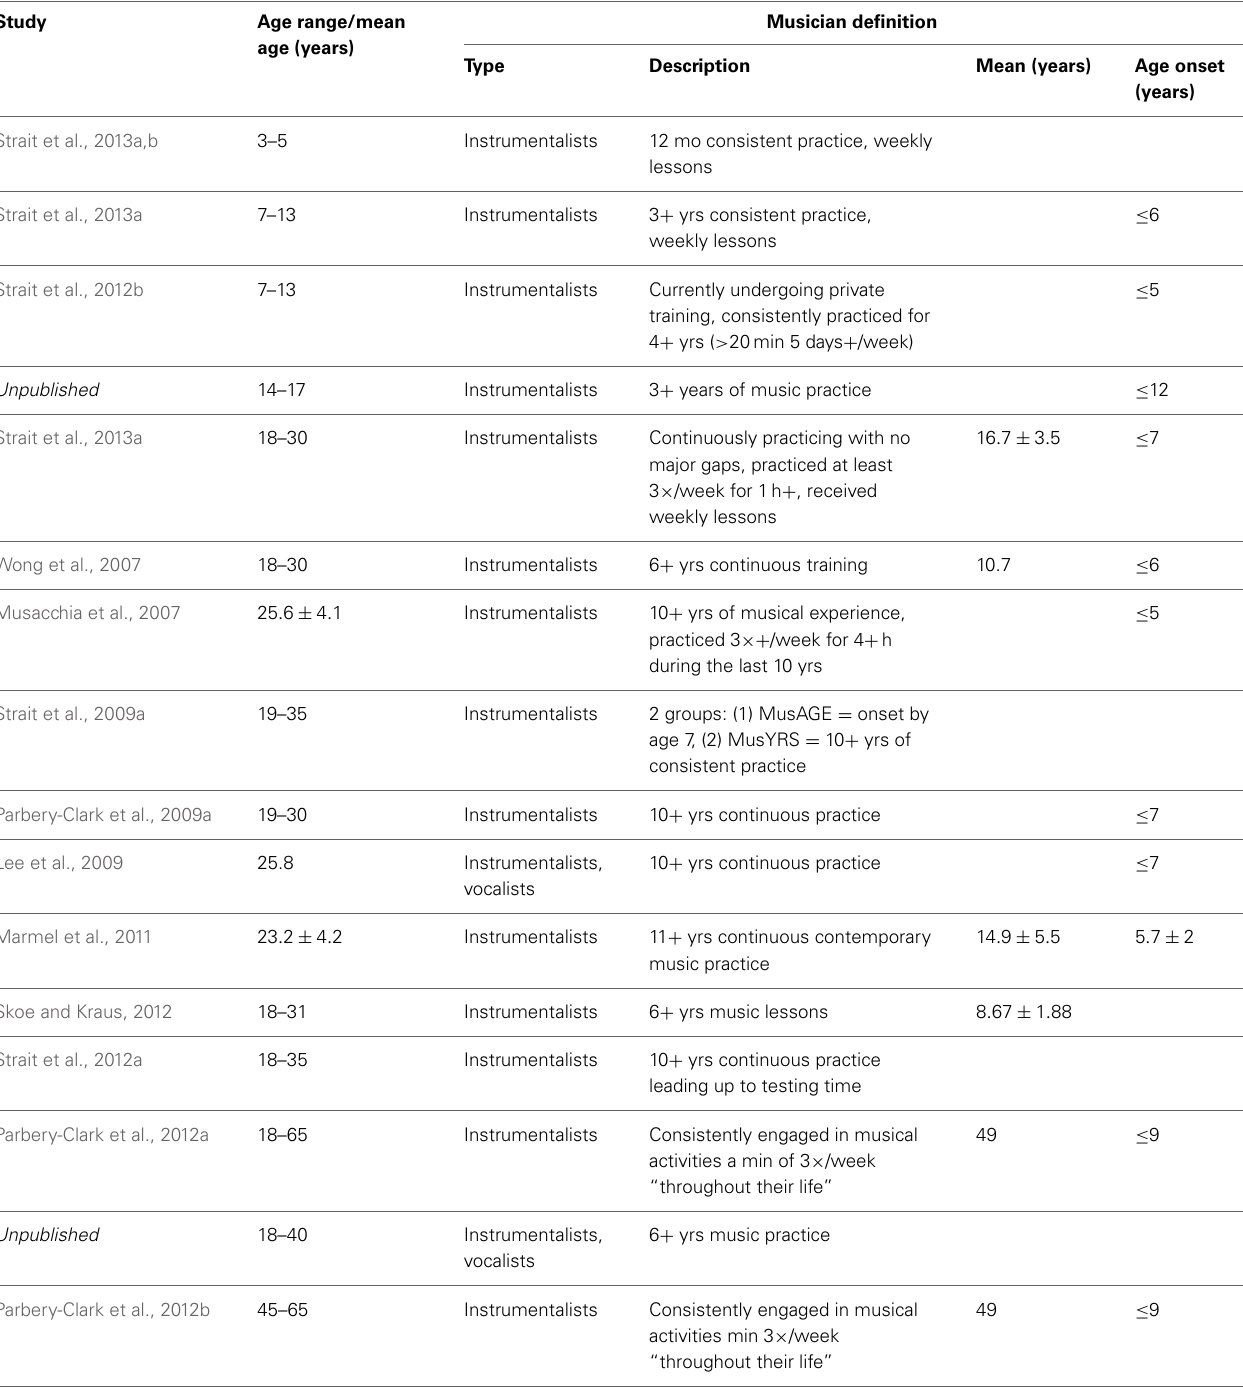
Table 2 | Musician definition by